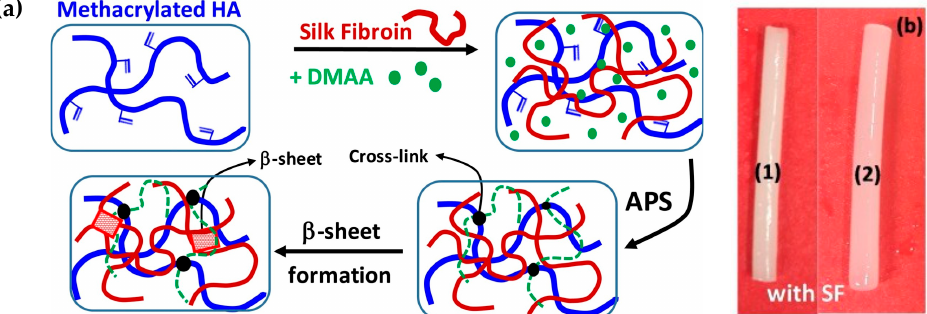
Figure 6. Schematic formation of HA-SF based hydrogel ( a ) and photographs of hydrogels with SF ( b ) [58]. Adapted with permission from Elsevier, 2019.